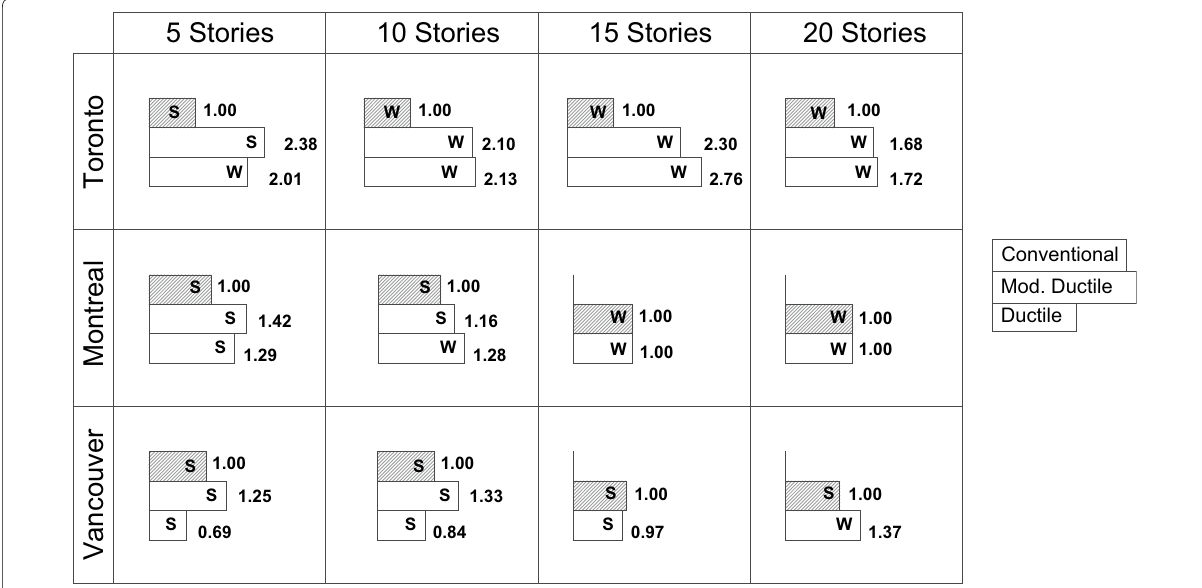
Fig. 6 The rebar constructability factor (C.F.) relative to a reference